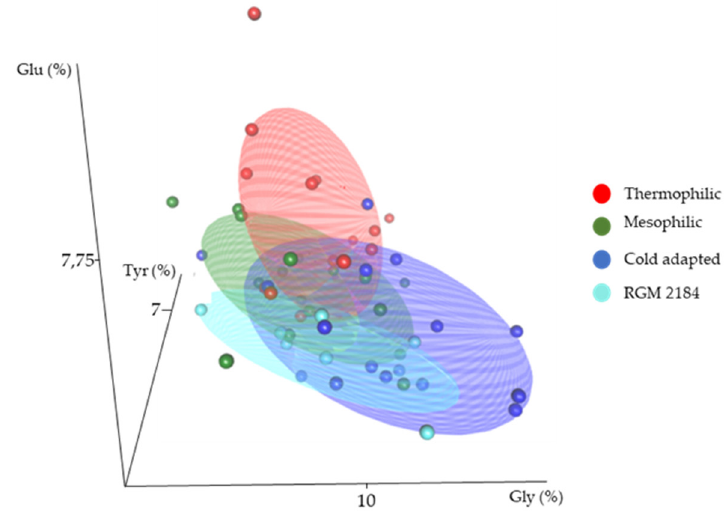
Figure 8. Three-dimensional scatterplot of cold-adapted (blue), mesophilic (green), and thermophilic (red) enzymes according to their amino acid composition, and identified enzymes secreted by B. pseudobassiana RGM 2184 (light blue). The axes correspond to the percentage of tyrosine (Tyr (%)), glutamic acid (Glu (%)), and glycine (Gly (%)) in the primary structure of enzymes.